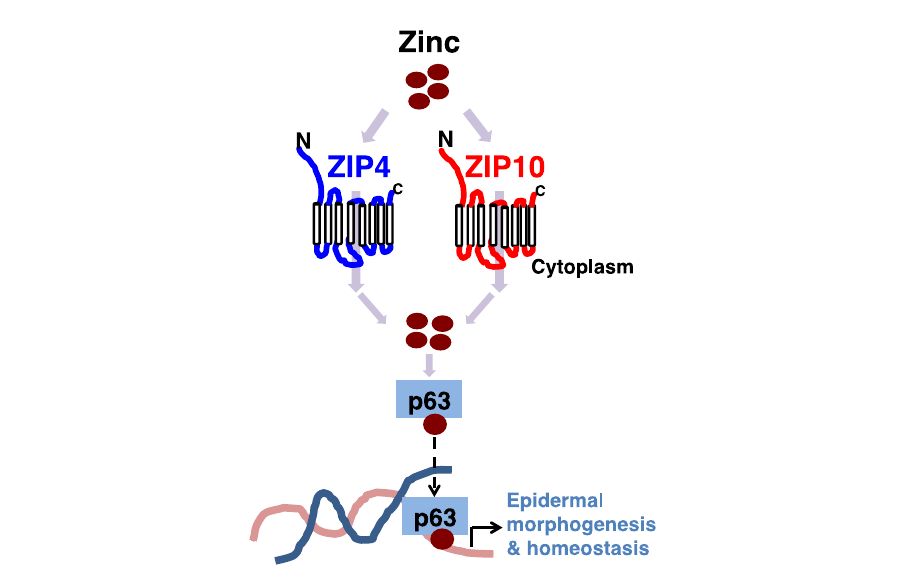
Figure 2. ZIP4 and ZIP10 support p63 activity for adult epidermal homeostasis. ZIP4 and ZIP10 supply zinc to epidermal master regulator p63 for their activity. Zinc deficiency leads to improper